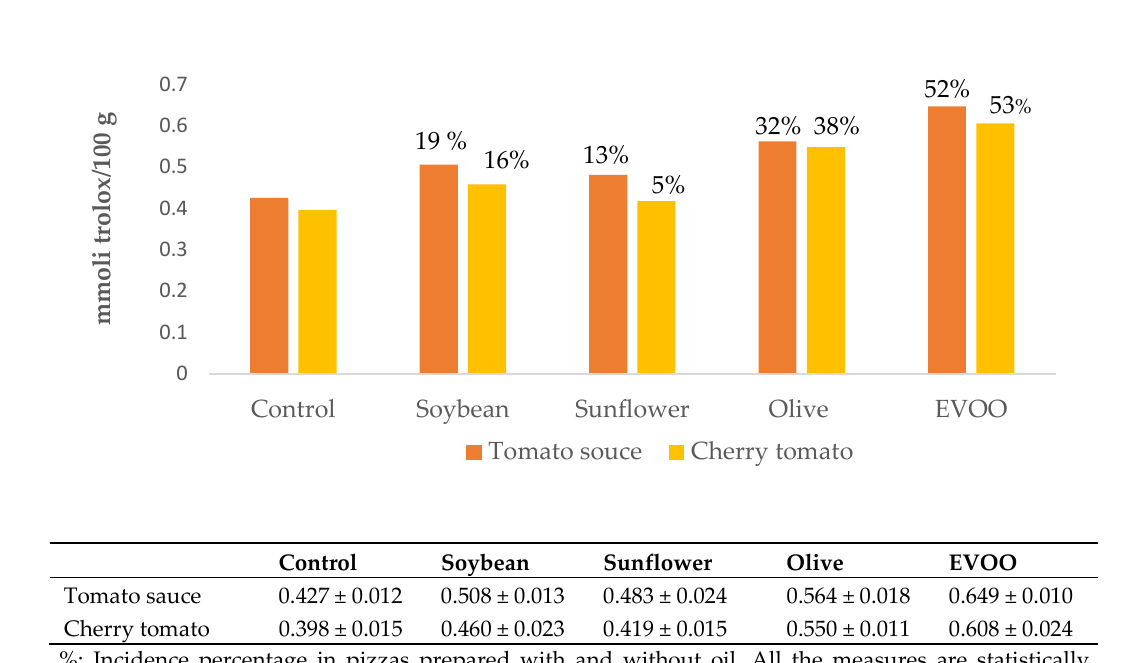
Figure 2. Antioxidant activity of the polyphenolic extracts.